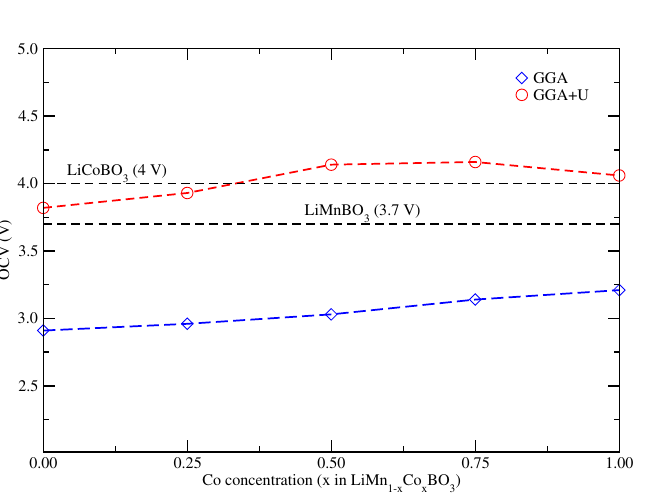
Figure 4. Experimental values (horizontal dashed lines in black) 23,48 and calculated OCV values versus cobalt concentration for the borate compounds LiMn 1 − x Co x BO 3 using GGA and GGA+U approximations. We used U d (Mn) = 4.5 eV and U d (Co) = 5.7